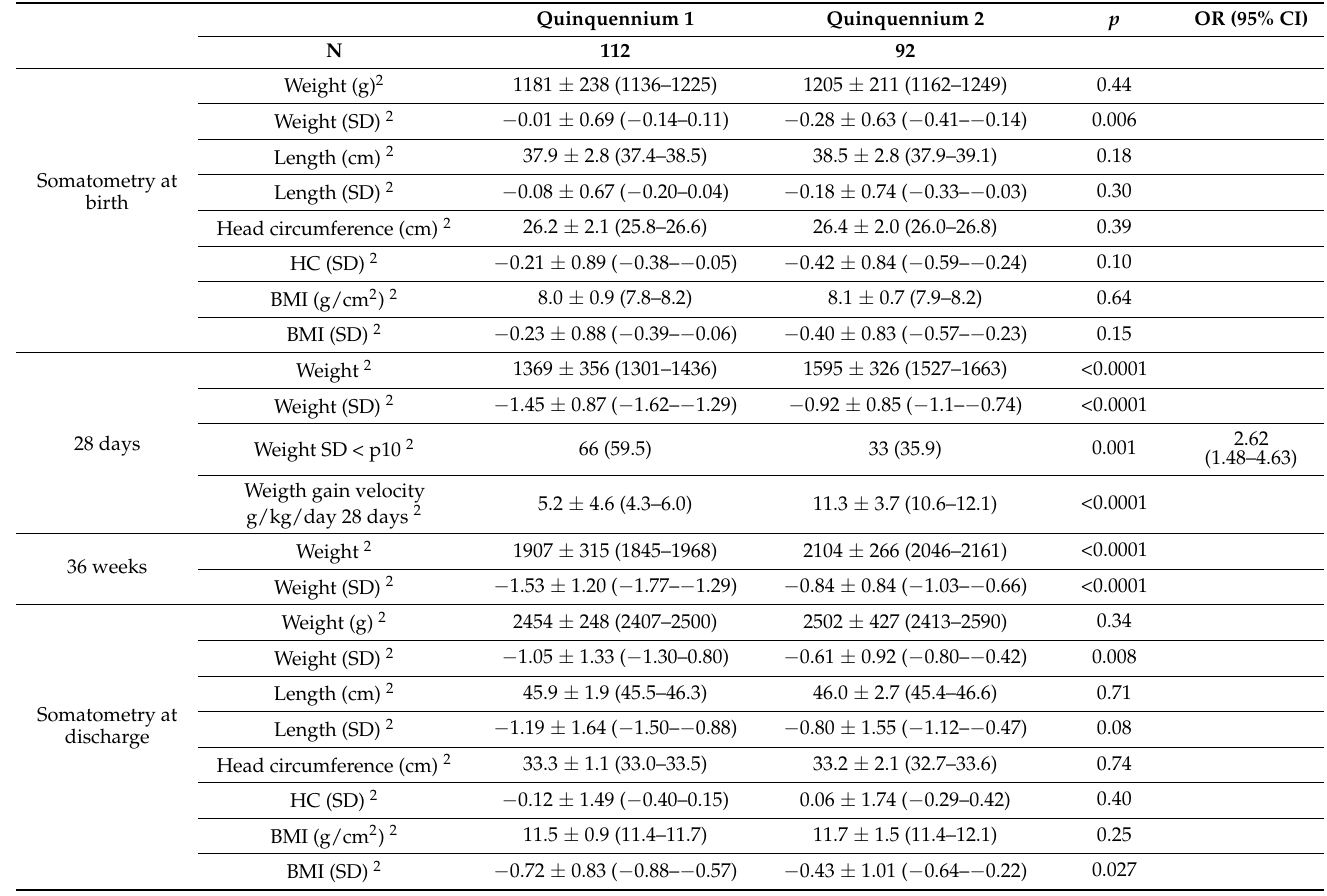
Table 2. 2002–2006 vs. quinquennium 2: